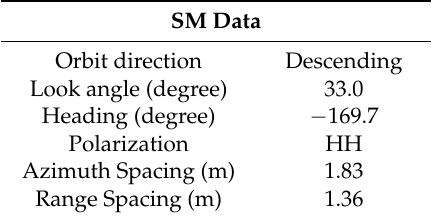
Table 3. Basic information on the acquired TerraSAR-X Stripmap (SM) datasets.